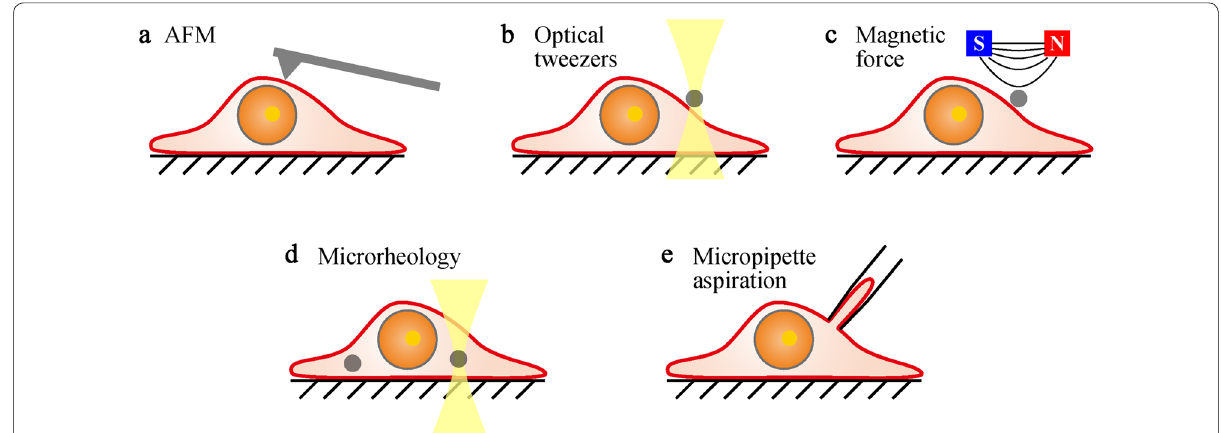
Fig. 1 Conventional measurement methods of cellular mechanical properties. a AFM. b Optical tweezers. c Magnetic tweezers. d Passive microrheology (left particle) and active (right particle with optical tweezers) microrheology. e Miropipette